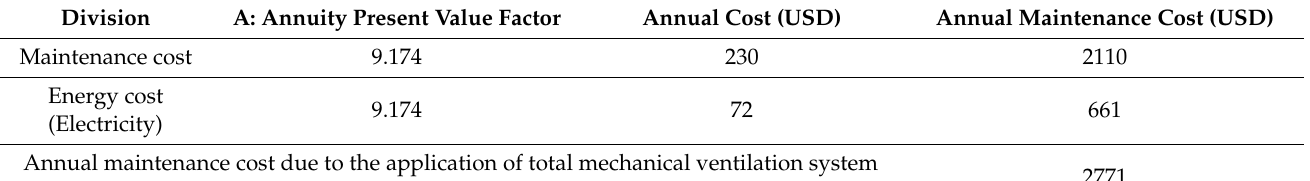
Table 5. Calculation of maintenance and energy cost applying the annuity present value